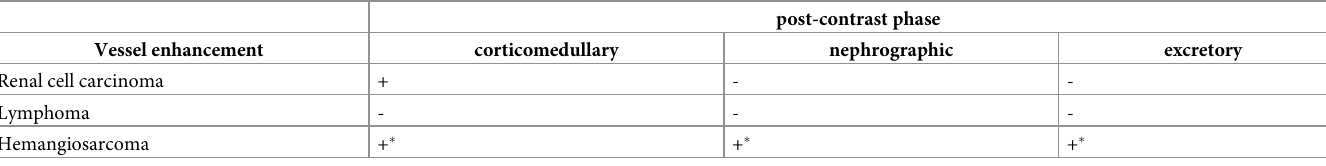
Table 2. Detail vessel enhancement features of each renal tumor